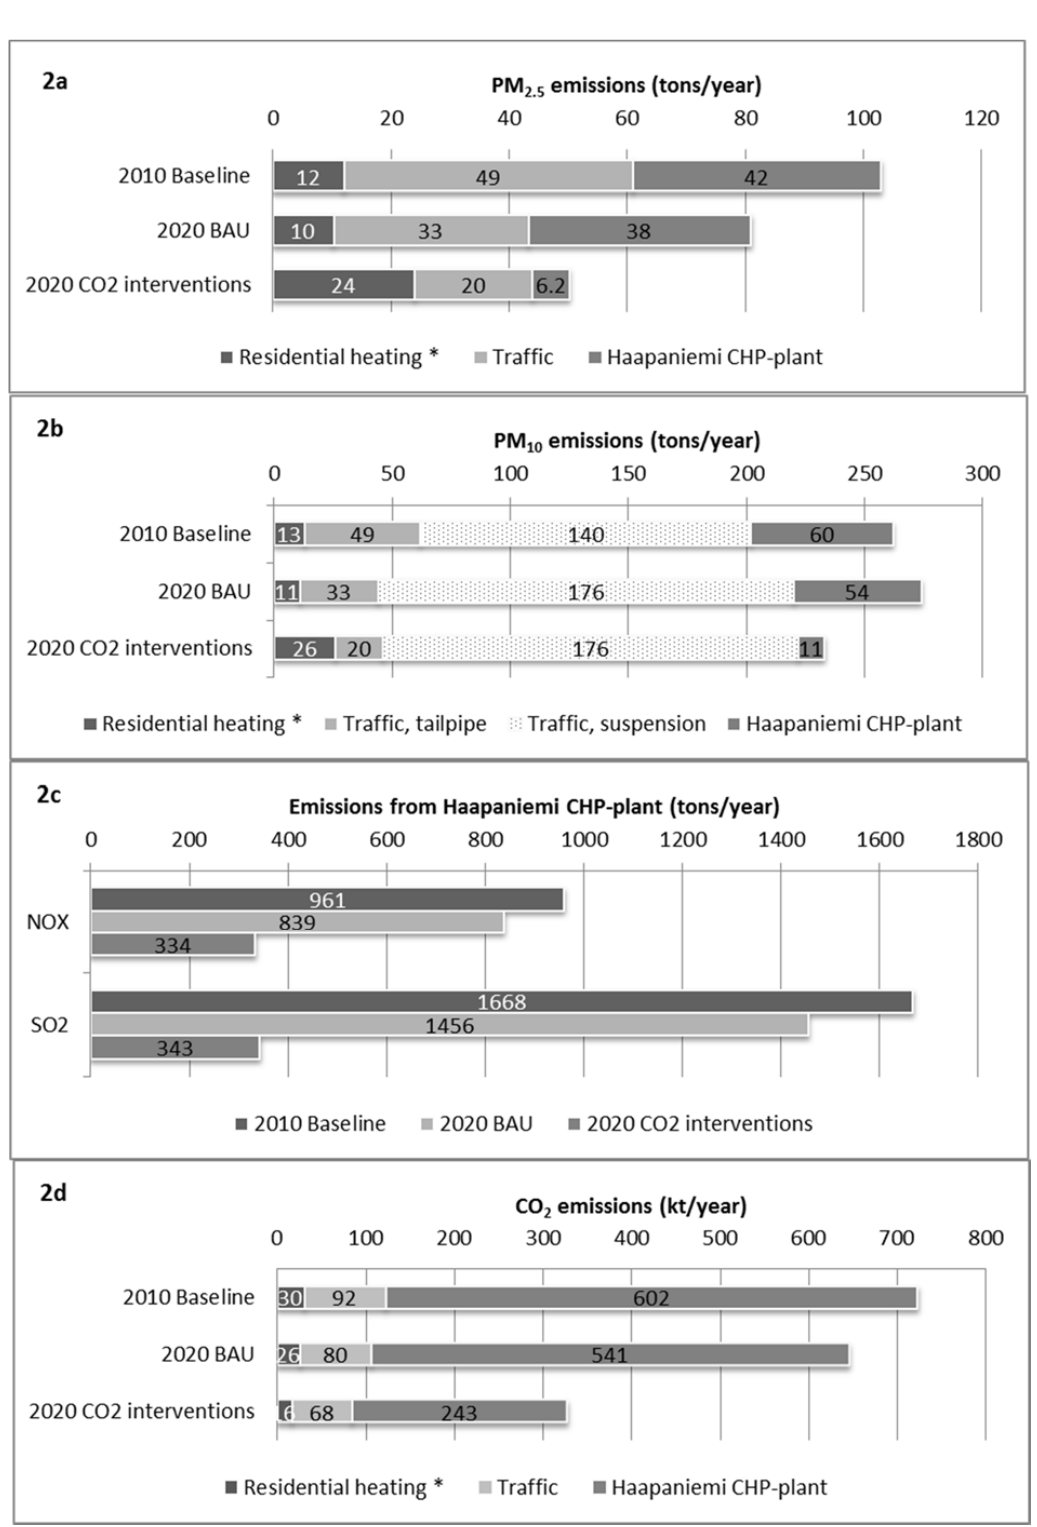
Figure 2. Emissions of ( 2a ) PM 2.5 , ( 2b ) PM 10 , ( 2c ) NOx and SO 2 and ( 2d ) CO 2 from the assessed sources in each scenario. * Residential heating without district heat.